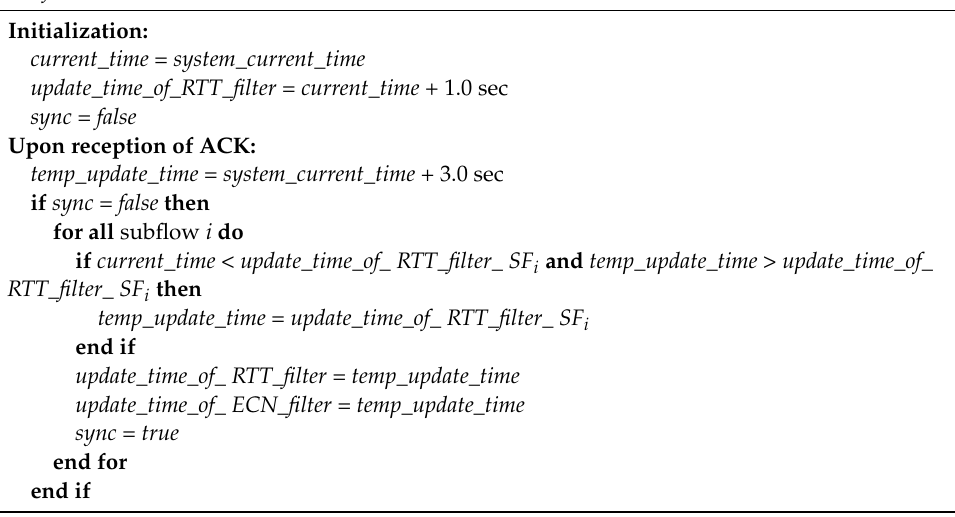
Algorithm 4: BA-MPCUBIC: Time synchronization between the SFs for RTT_filter, ECN_filter,